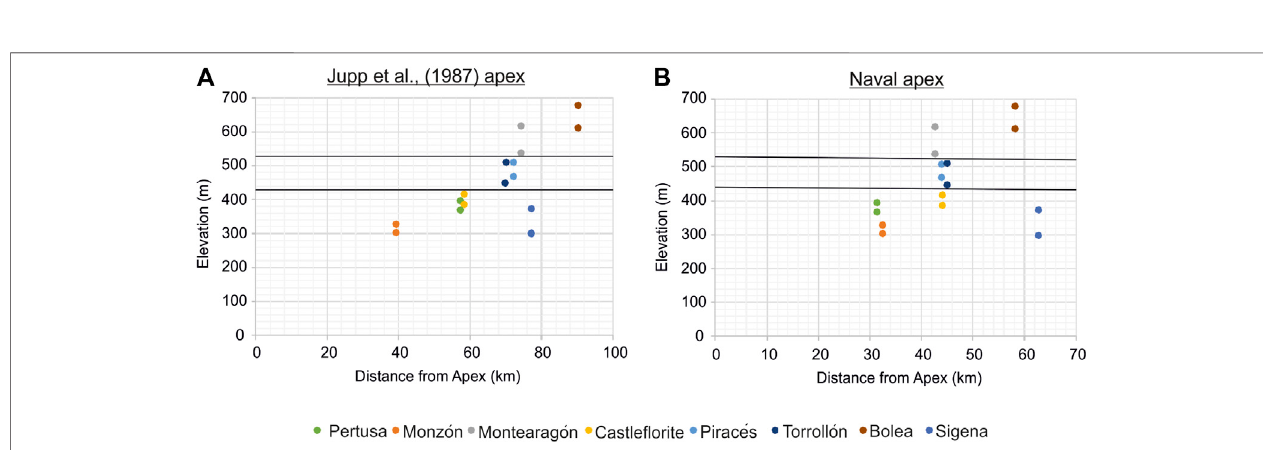
FIGURE 3 | Graphs showing relative vertical position of each locality studied within the general stratigraphic column. Note dots depict the bottom and top of each sedimentarylog.Blacklinesdepictthreebroadstratigraphichorizons(seetextfordiscussion).Leftplot (A) showsthepositionofeachlocalitystudiedfromthecalculated Jupp et al. (1987) apex. Right plot (B) the position of revised apex position (Naval) based on fi eld observations and facies distributions.